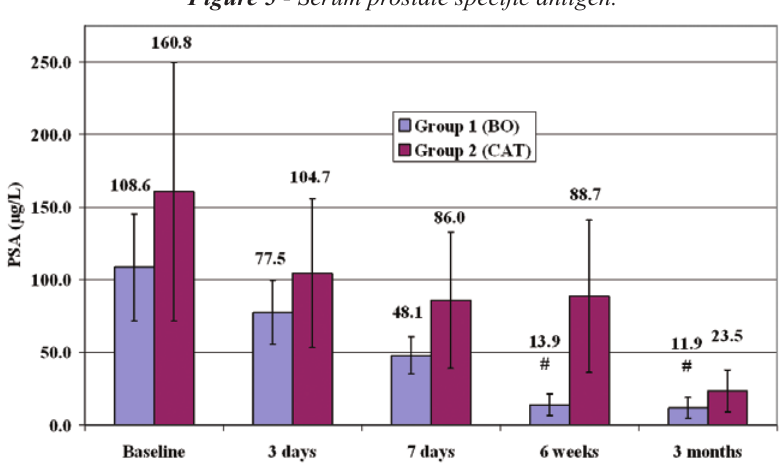
Figure 5 - Serum prostate specific antigen.